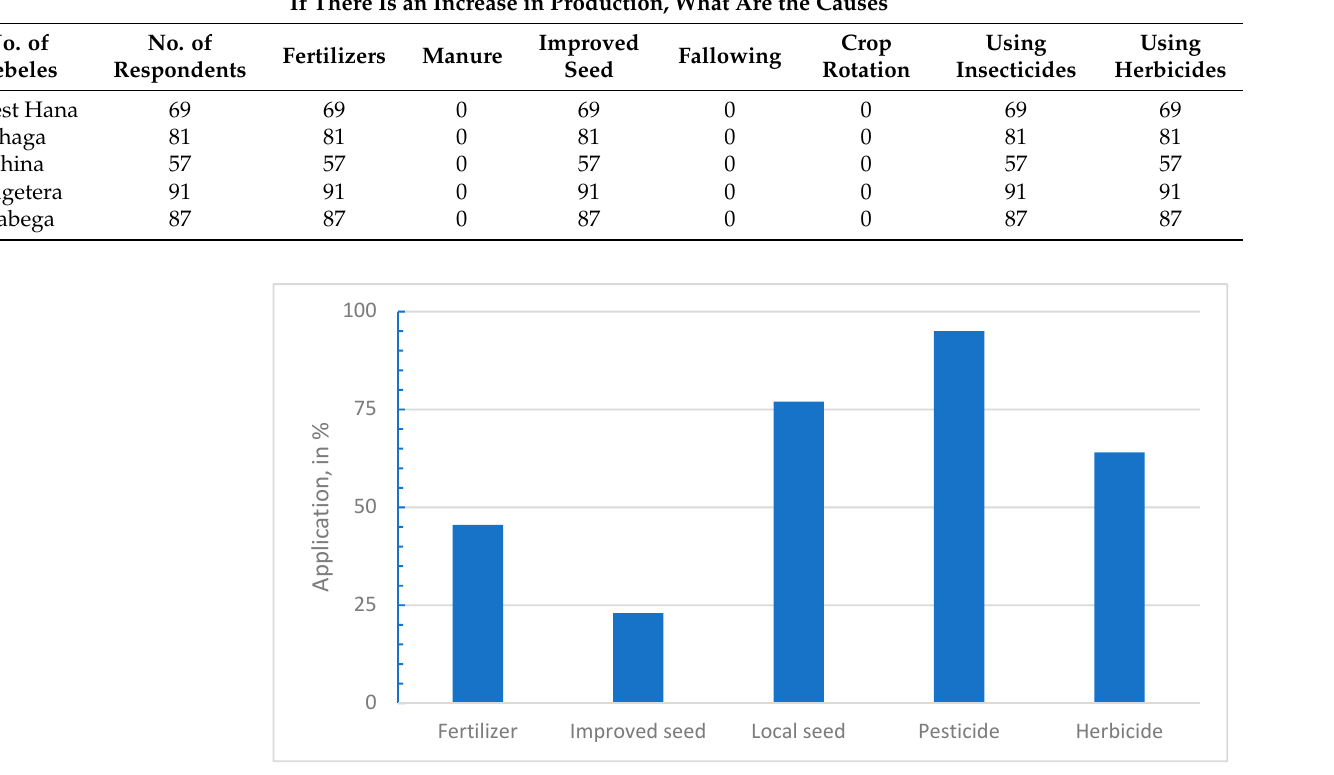
Figure 6. The chemical inputs application for rice in the Fogera floodplain.